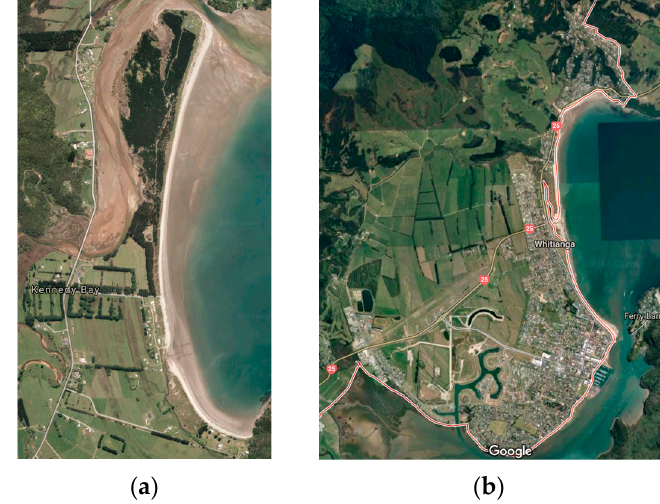
Figure 2. Comparison between ( a ) Kennedy Bay and ( b ) Whitianga/Mercury Bay (Google maps, 2017).